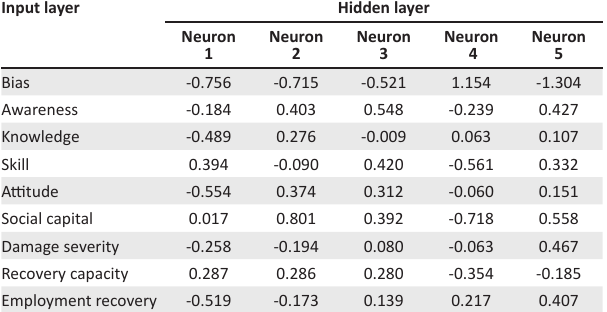
TABLE 7: Estimated coefficients by the neural network for hidden layer, Bam.